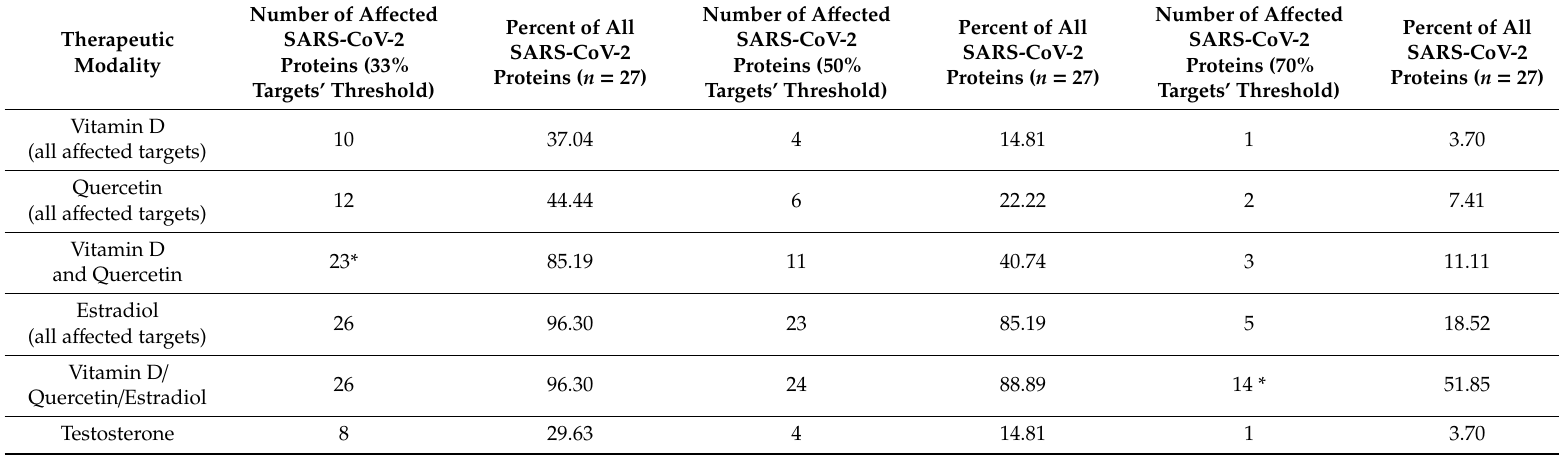
Table 2. Number of drug-specific and common SARS-CoV-2 viral proteins with predicted interference by vitamin D, quercetin, and estradiol treatments.